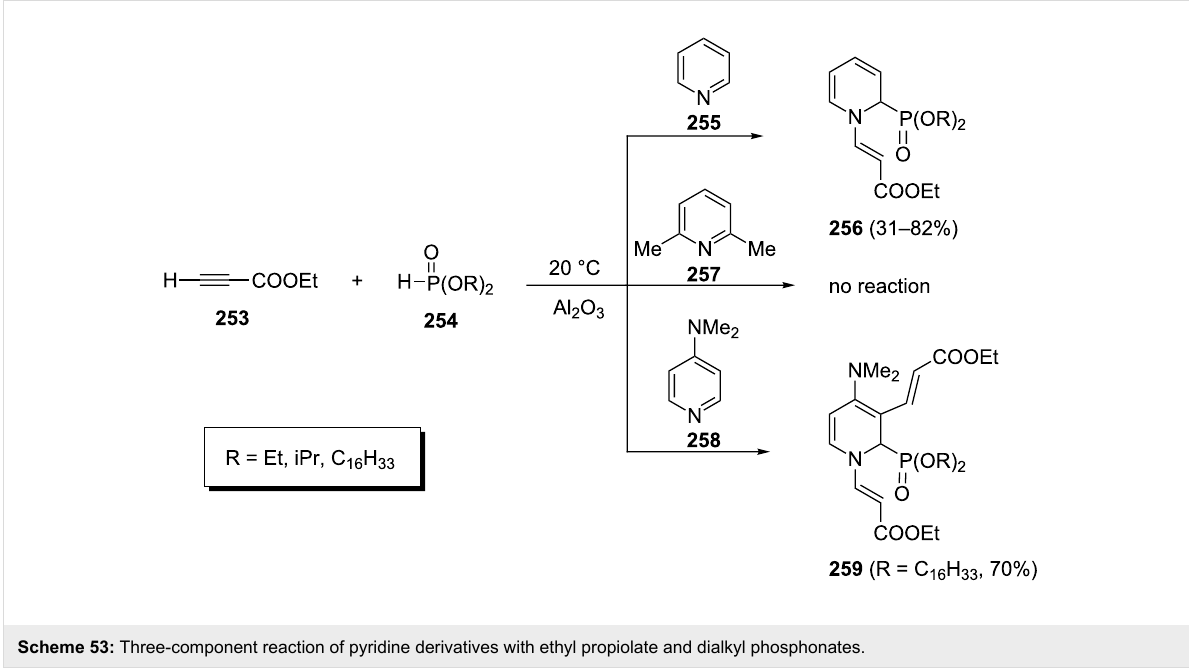
Scheme 53: Three-component reaction of pyridine derivatives with ethyl propiolate and dialkyl phosphonates.